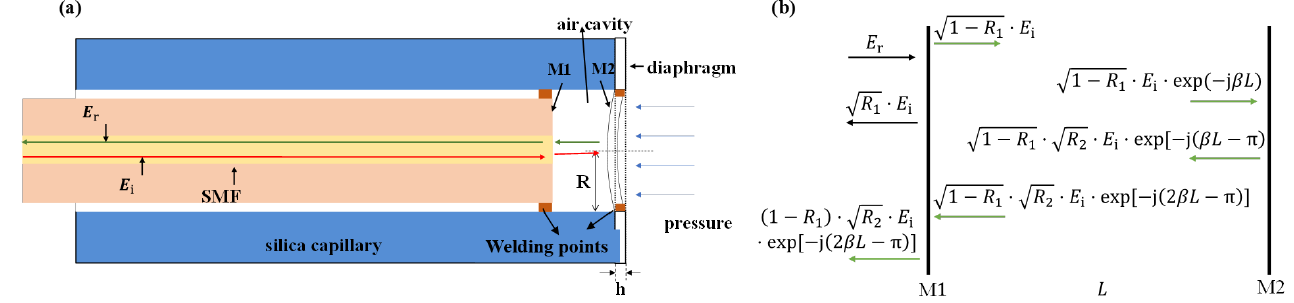
Figure 1. Diaphragm-based pressure sensor: ( a ) The structure of the sensor; ( b ) interference principle of the FP cavity.